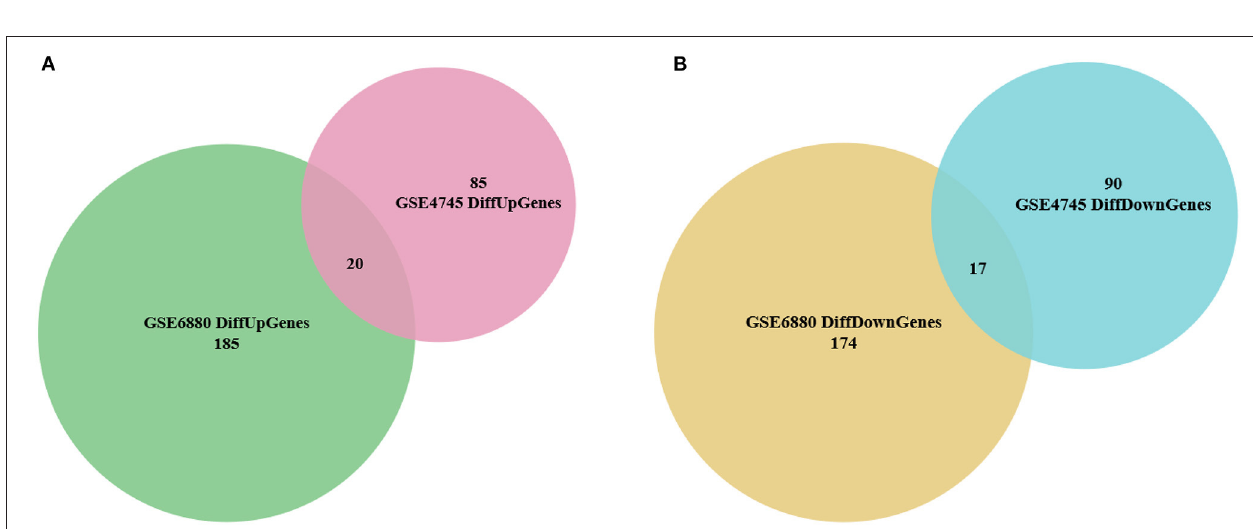
FIGURE 1 | Identification of overlapped differentially expressed genes (DEGs) between normal and diabetic heart samples in datasets GSE4745 and GSE6880. (A) Venn diagram of 20 overlapped up-regulated genes in GSE4745 and GSE6880. (B) Venn diagram of 17 overlapped down-regulated genes in GSE4745 and GSE6880.